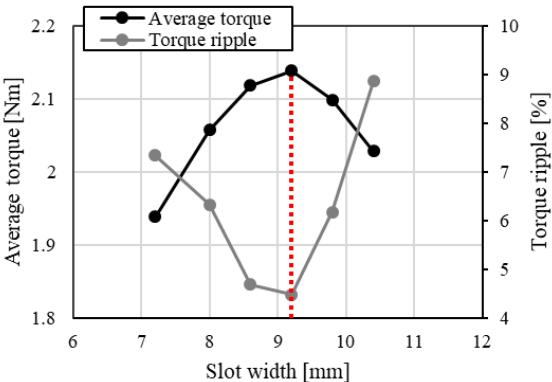
Figure 3. Average torque and torque ripple with respect to the slot width.